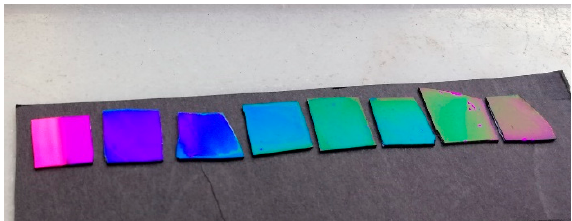
Figure 3. Image of silicon nitride surfaces after immersing the silicon nitride wafers in the polymer- ization medium for 2 to 8 h. The left surface corresponds to the bare silicon nitride surface.